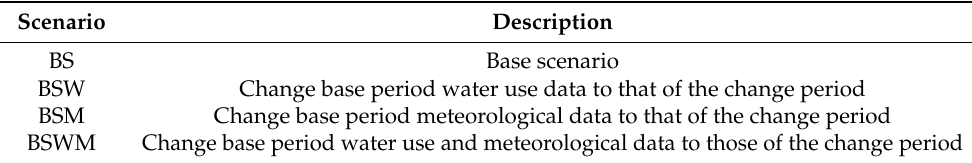
Table 2. Settings of scenarios for the multifactor attribution analysis.